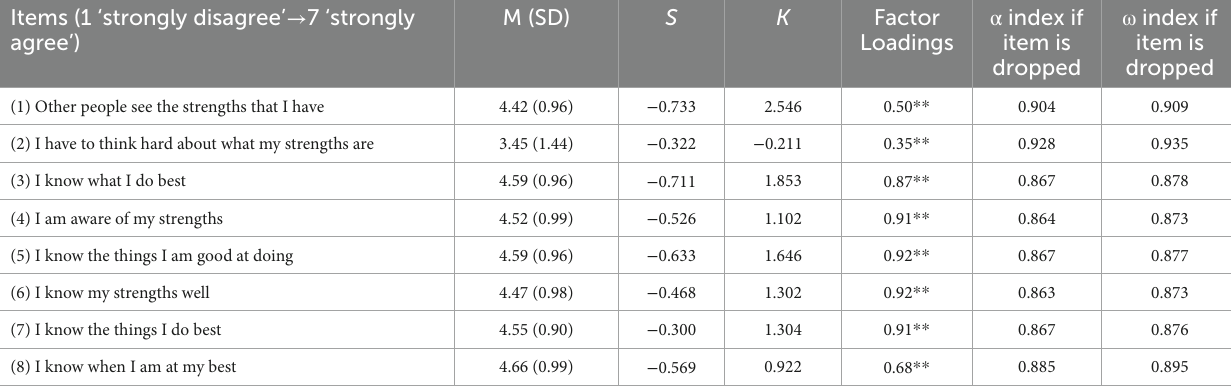
TABLE 5 Descriptive statistics and factor loadings of the strengths knowledge scale (study